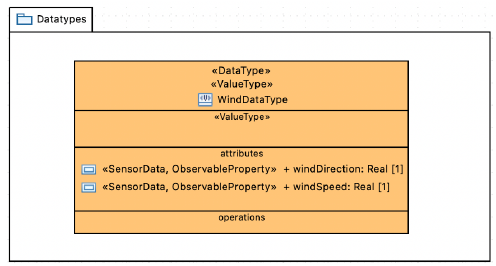
Figure 15. Datatypes Package.